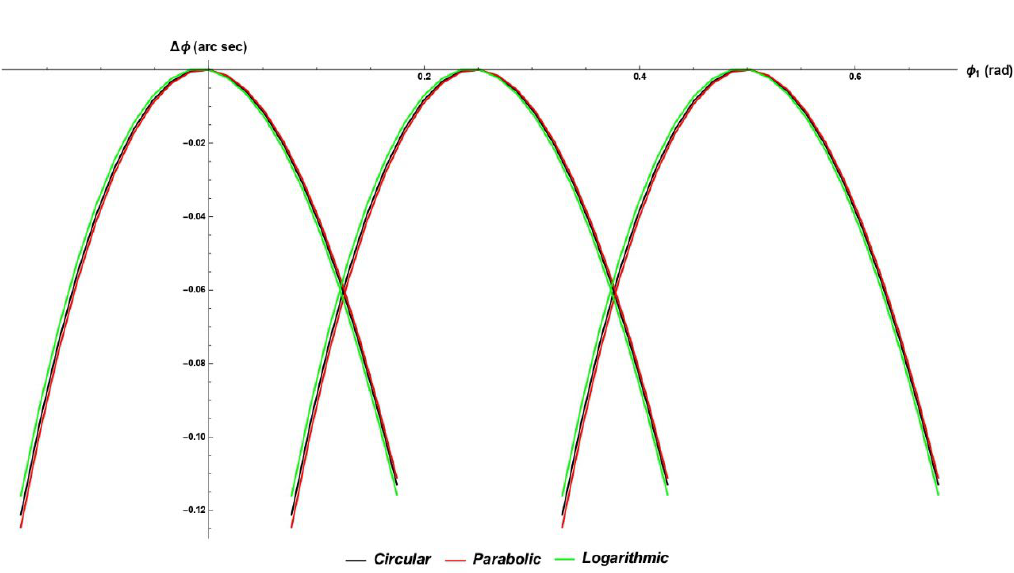
Figure 11. TE of crowned spur gear pair for the circular ( blue ), parabolic ( red ), and logarithmic ( green ) crowning function for a 0.4° (7.0 mrad) angular out-of-plane misalignment error. In Figure 12, the same trend was observed as in the case of in-plane misalignment.